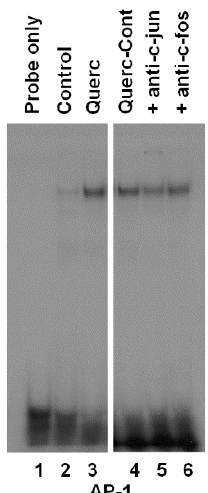
Figure 3. E ff ects of quercetin on the formation of protein / DNA complexes between FRTL-5 cell nuclear extracts and an AP-1 (Activator protein-1) consensus oligonucleotide. Radiolabeled oligonucleotide was incubated with nuclear extracts from cells cultured in 6H5% medium (control), cells treated with 10 µ M quercetin (Querc) for 48 h; cells treated with quercetin plus normal rabbit polyclonal antiserum (Querc-Cont) or antibodies against c-jun ( + anti-c-jun) or c-fos ( + anti-c-fos). Lane 1 contains the probe alone.